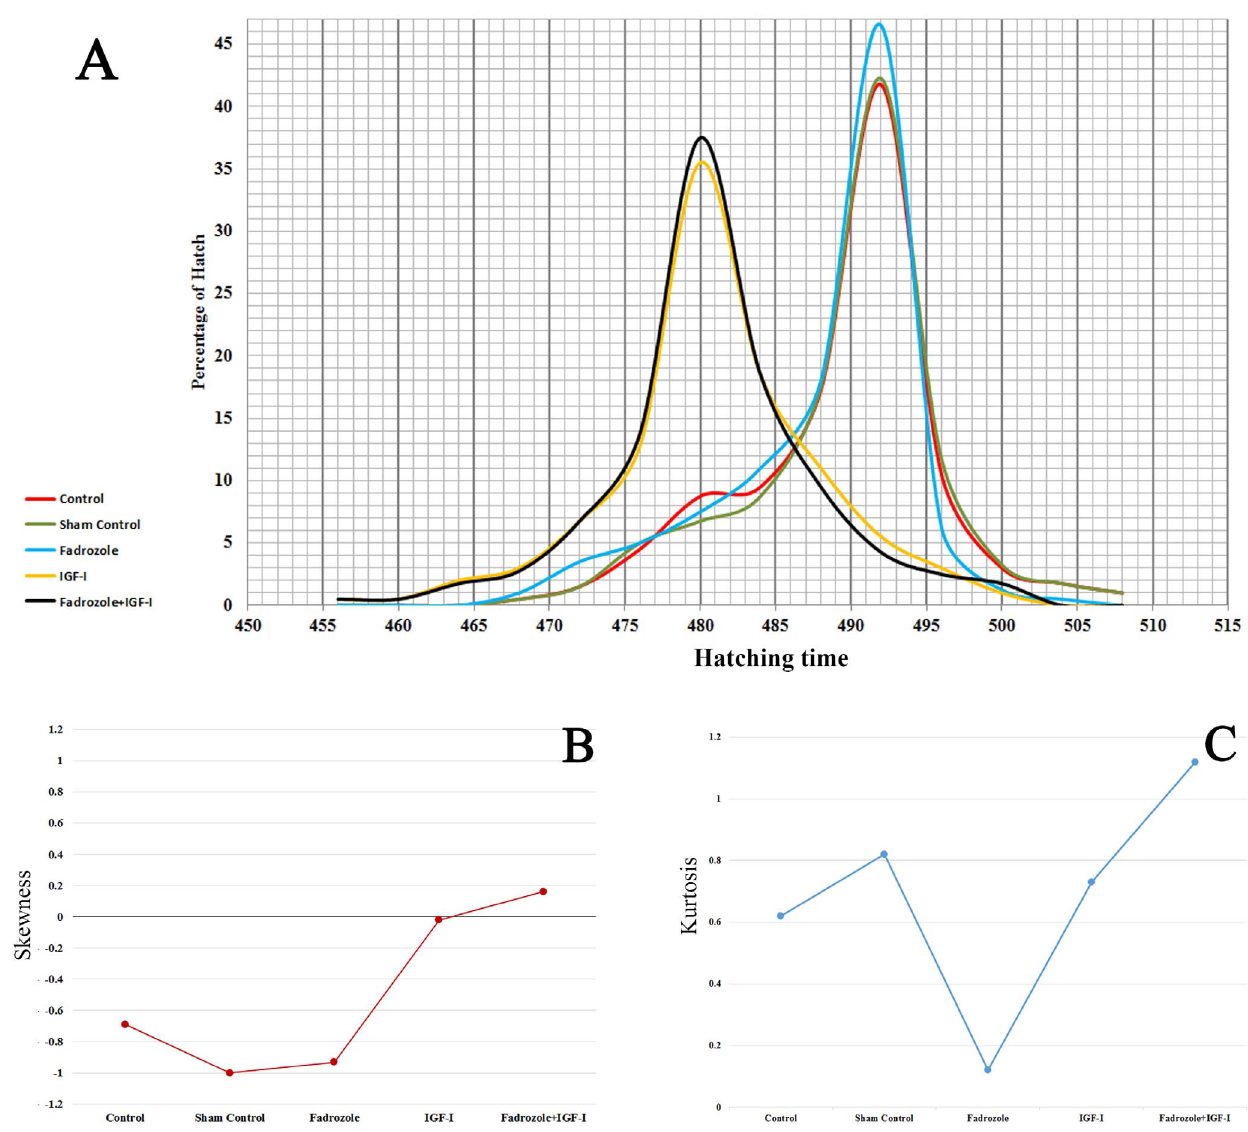
Figure 1. Distribution frequencies of the chicken hatching time. (A) Graphical presentation of hatching time in Control, Sham injection control, Fadrozole (0.1 mg), IGF-I (100 ng), Fadrozole (0.1 mg) + IGF-I (100 ng) groups. All injections were carried out on Day 3 of egg incubation over a long distance from the embryo location. (B) Skewness and (C) kurtosis criteria of the distribution frequencies.